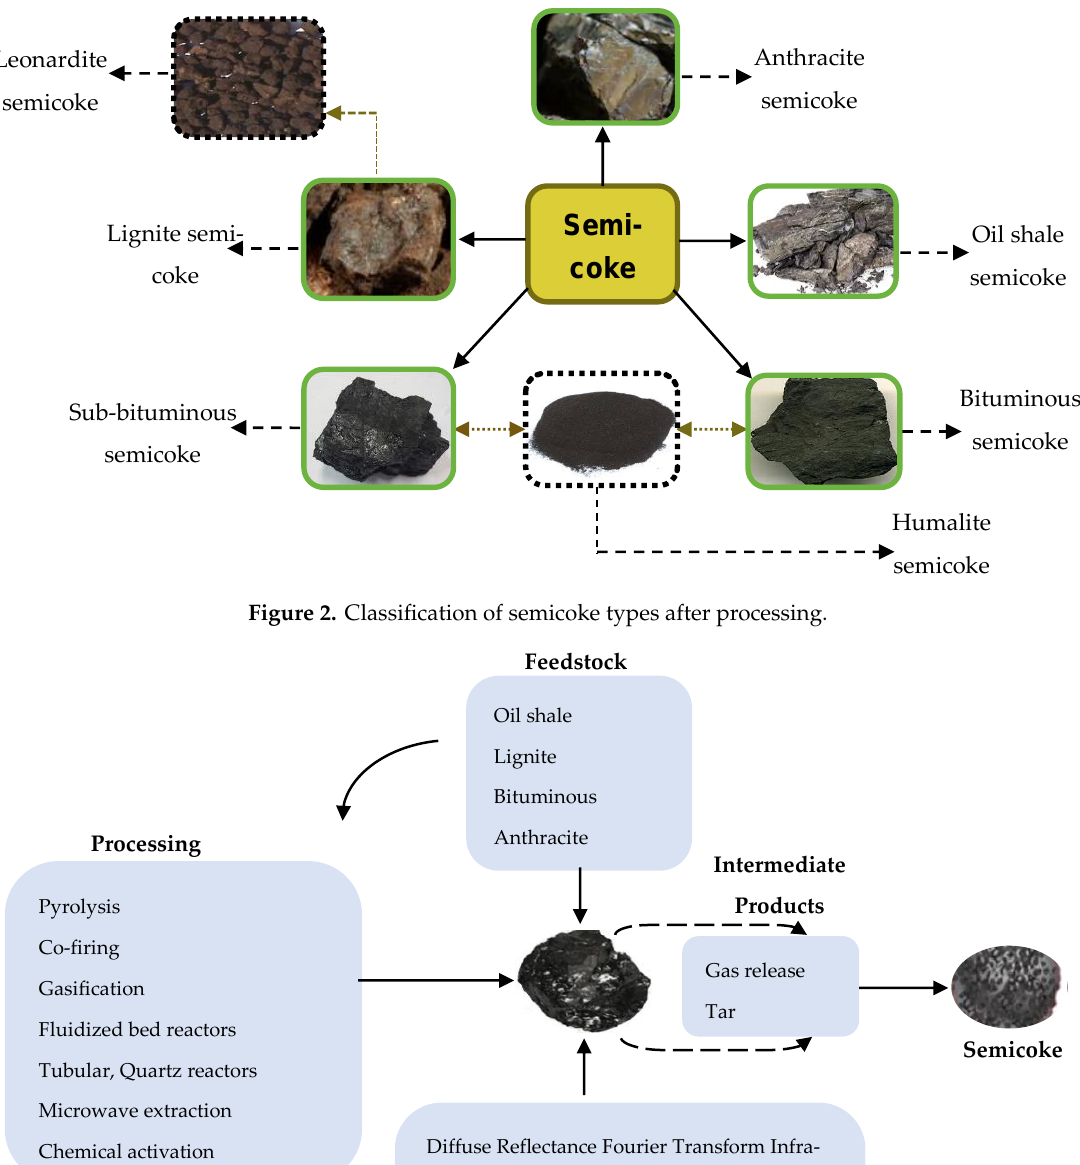
Figure 3. Flow process of some semi coke preparation factors.